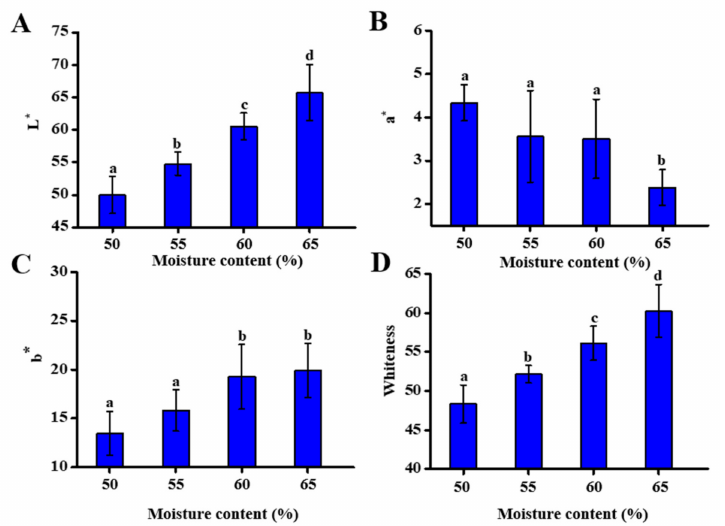
Figure 3. Effect of moisture content on the color attributes of fish filets: L* ( A ), a* ( B ), b* ( C ) and whiteness ( D ). Different letters represent significant differences ( p <